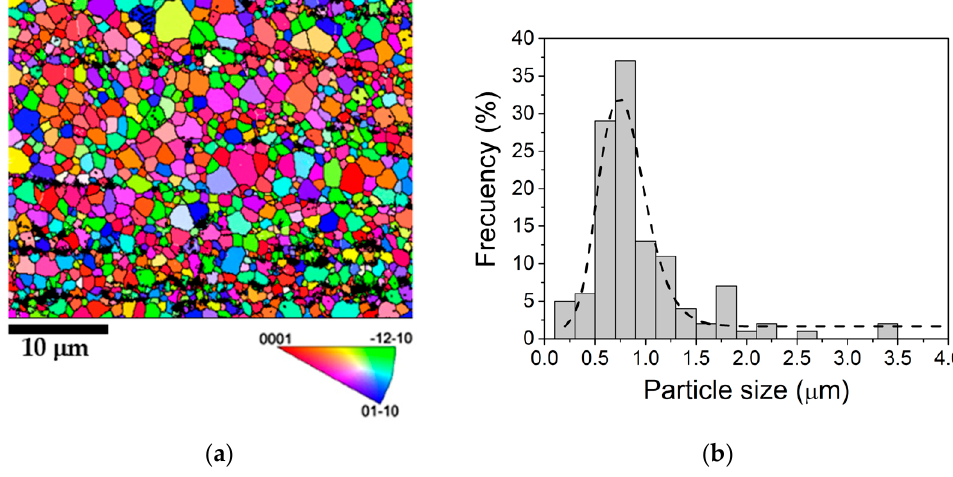
Figure 3. XRD (X-ray diffraction) pattern of EZ51 as-cast ingot (Cu-K α radiation).